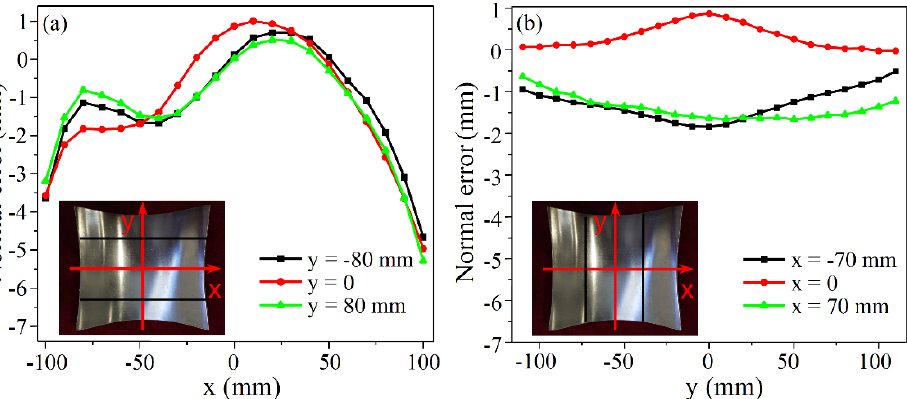
Figure 16. Normal error of the profile curves for negative Gaussian curvature surface: ( a ) Longitu- dinal; ( b ) Transverse.